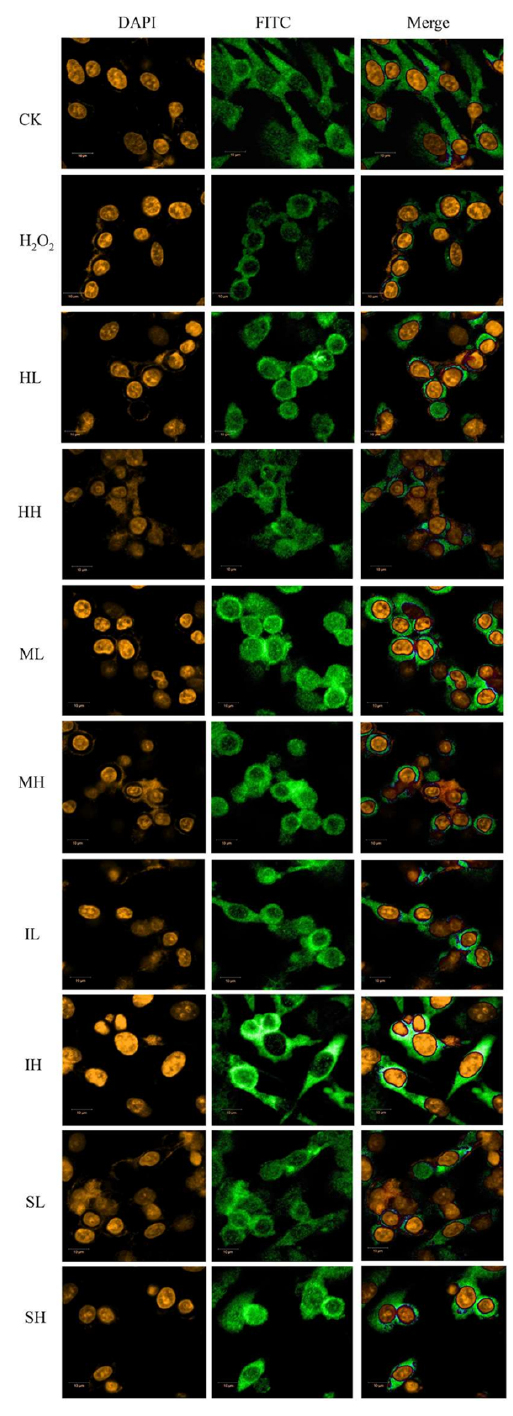
Figure 4. The immunofluorescence assay of Nrf2 in different groups. ( × 400) PC12 cells were incubated with PhGs (0.1 and 10 µ g/mL) for 24 h, and then incubated with 200 µ M H 2 O 2 for another 2 h after the PhGs were removed. Nrf2 localization was observed under an inverted fluorescence microscope. CK: normal group, H 2 O 2 :H 2 O 2 treated group, HL: 0.1 µ g/mL salidroside treated group, HH: 10 µ g/mL salidroside treated group, ML: 0.1 µ g/mL acteoside treated group, MH 10 µ g/mL acteoside treated group, IL: 0.1 µ g/mL isoacteoside treated group, IH: 10 µ g/mL isoacteoside treated group, SL: 0.1 µ g/mL echinacoside treated group, SH: 10 µ g/mL echinacoside treated